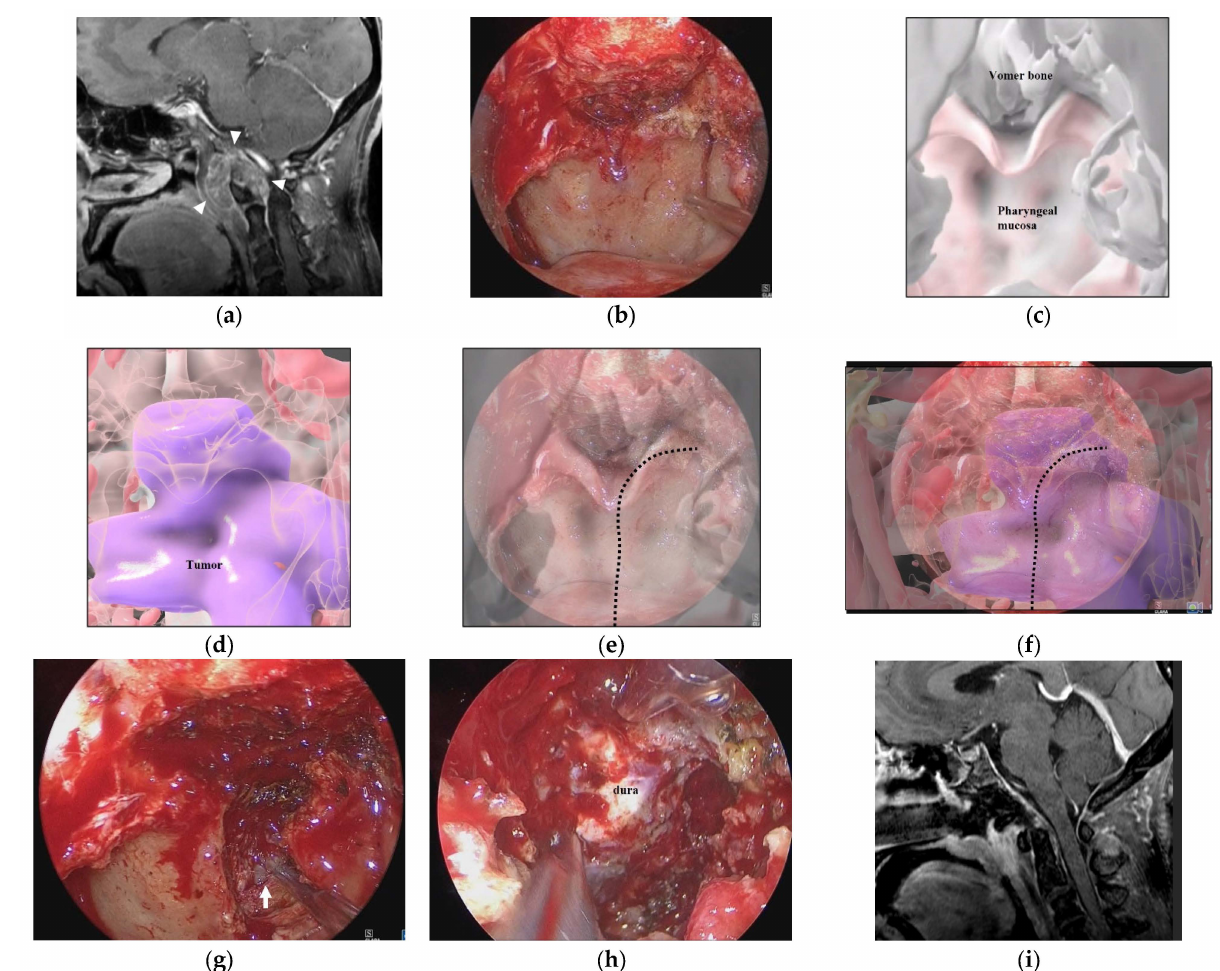
( c ) Fusion image of the endoscopic view ( b ) and the semi-transparent 3DCG model shows extension of the pituitary tumor into the right cavernous sinus (black arrowheads) beyond the bone removal line. ( d ) Endoscopic view after additional bone removal (black arrowheads). ( e ) The right ICA (white arrow) is exposed after resection of the pituitary tumor around the cavernous sinus. ( f ) Coronal section of postoperative gadolinium-enhanced T1 weighted image shows total removal of the tumor. ICA = intracranial artery.